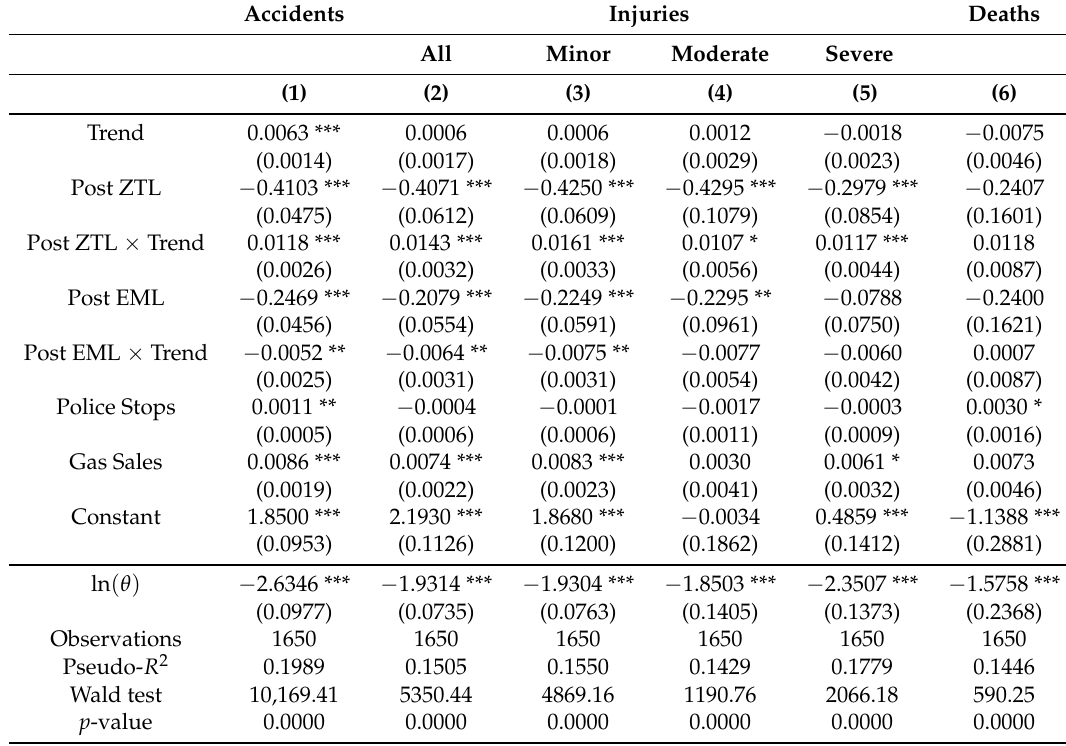
Table 2. Negative Binomial